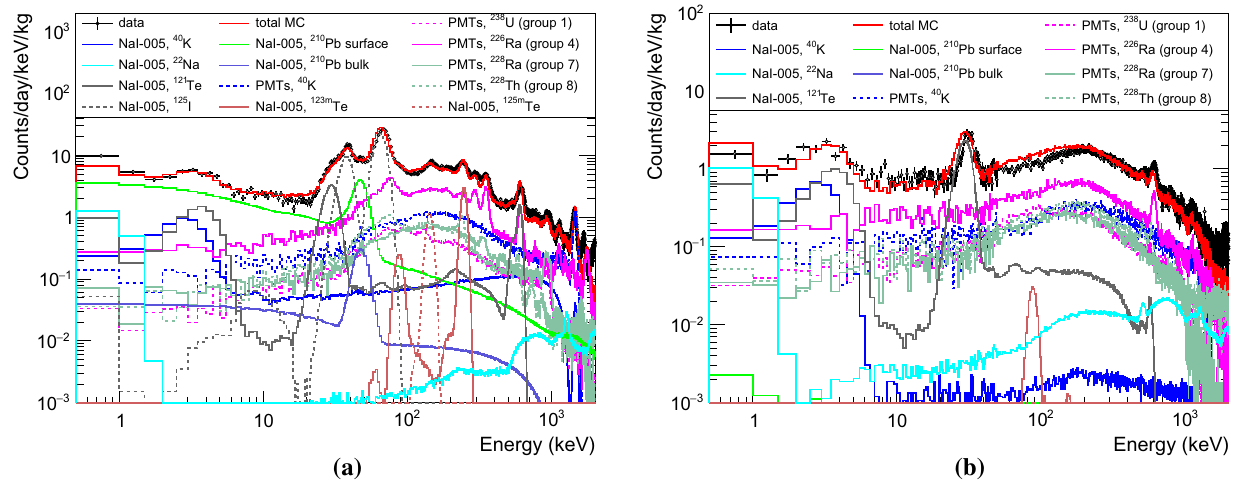
Fig. 7 Measured background spectrum ( open black circles ) fitted with all of simulated background spectra for single-hit events ( a ) and multiple-hit events ( b